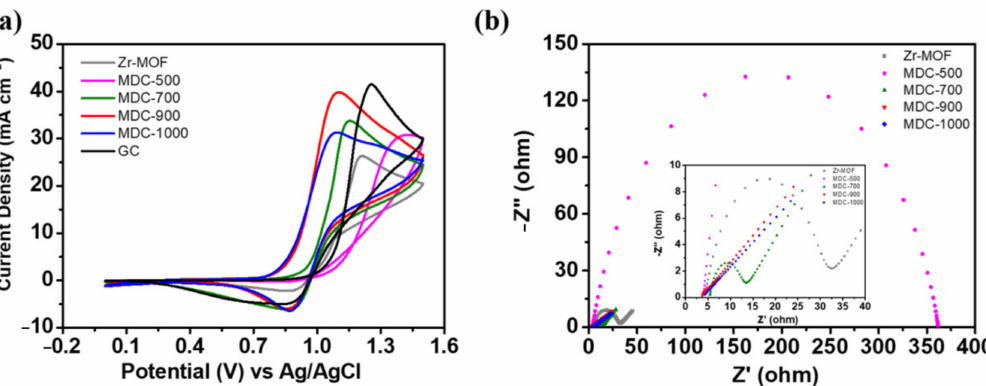
Figure 6. Cycle voltammetry (CV) curves of ( a ) positive electrode obtained at the scan rate of 10 mV s − 1 , ( b ) EIS curves of various samples obtained at a potential of polarization 1.0 V. The electrolyte was composed of 1.6 M VOSO 4 plus 4.6 M H 2 SO 4